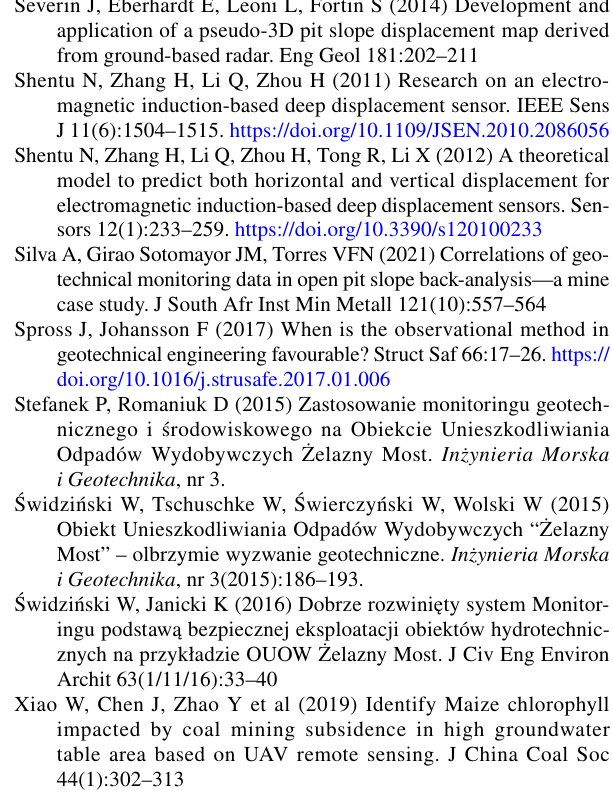
table area based on UAV remote sensing. J China Coal Soc